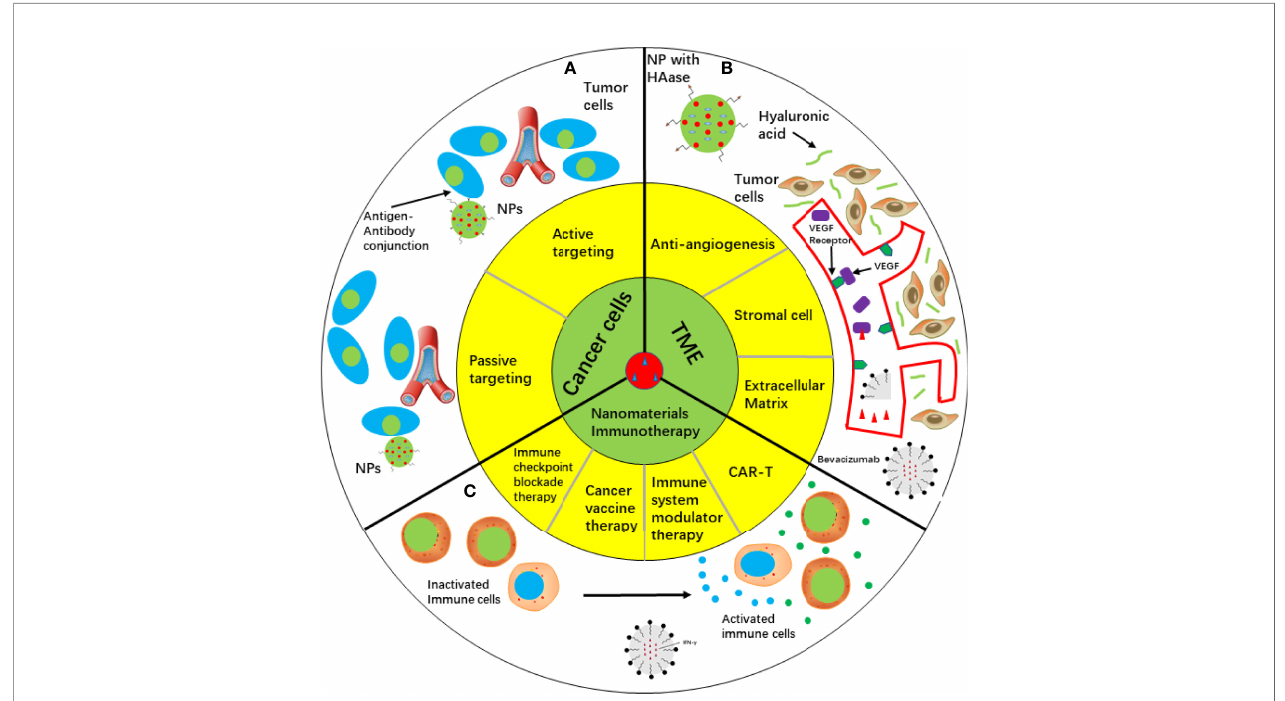
FIGURE 2 | Cancer therapy approaches depending on nanomaterials. (A) Targeting cancer cells by passive targeting or active targeting. (B) Targeting TME, such as anti-angiogenesis, stromal cell and extracellular matrix. Bevacizumab was loaded in liposome and conjugated with VEGF to suppress angiogenesis. HAase was fabricated onto NP surface and penetration ability of NP was increased. c IFN- g as an immune regulator delivered by liposomes activated immune cells in cancer immunotherapy. HAase, hyaluronidase; IFN- g , Interferon gamma; NP, nanoparticle; TME, tumor microenvironment; VEGF, vascular endothelial growth